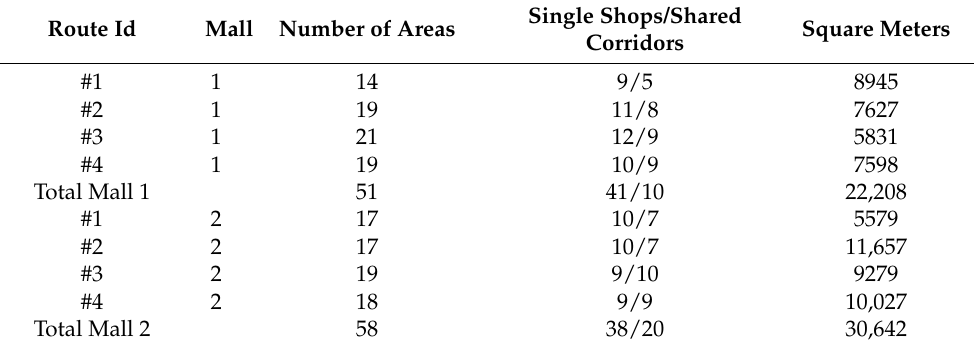
Table 2. Routes implemented for validation purposes, showing both the number of areas and the number of shared corridors where RSSI samples were acquired. The square meters covered for each validation route are also